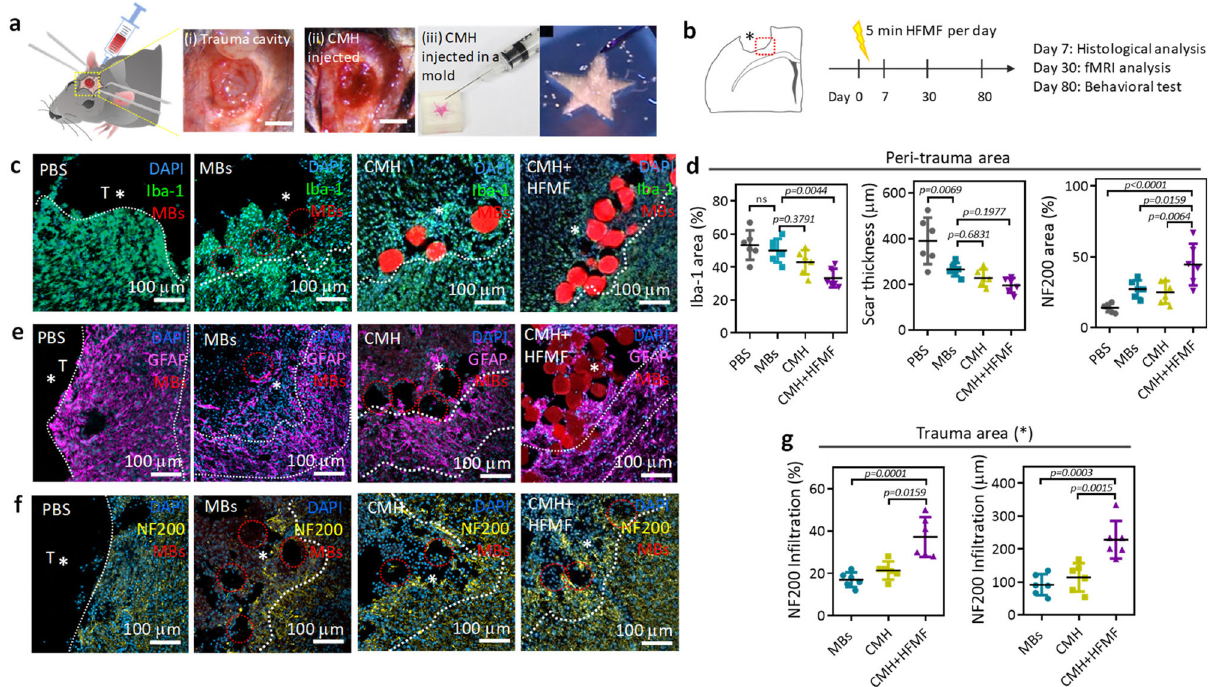
Fig. 5 | Animal study. a Images of the TBI cavity before and after implanting the CMH scaffold (left panel). Images of CMH injected into a star-shaped mold via a syringe (right panel). b Schematic of the in vivo experimental timeline, including the sacri fi ce and analysis time points. c Fluorescence images of Iba-1 immunos- taining after treatment with PBS, MB, CMH, and CMH+HFMF. d Analysis of Iba-1,